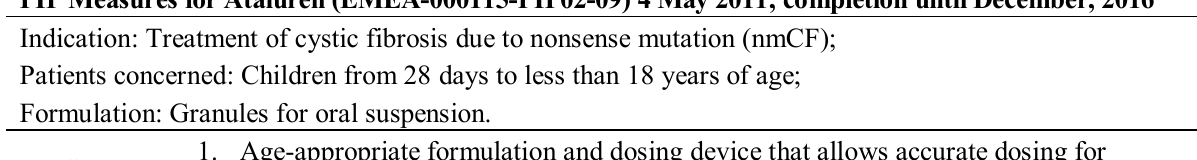
Table 7. PIP measures for